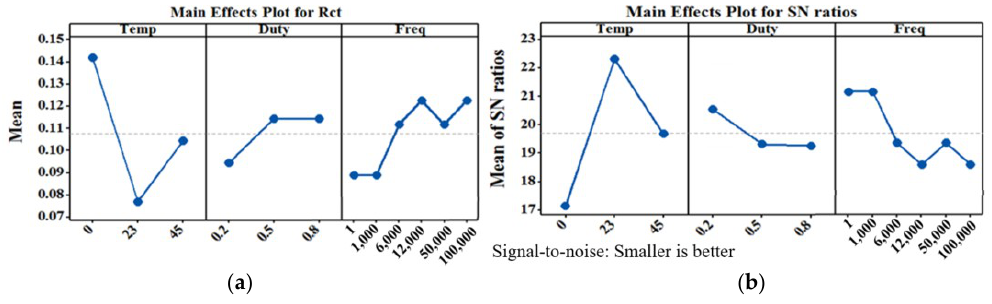
Figure 11. ( a ) Main effects plot for R ct ; ( b ) Main effects plots of SN for R ct .